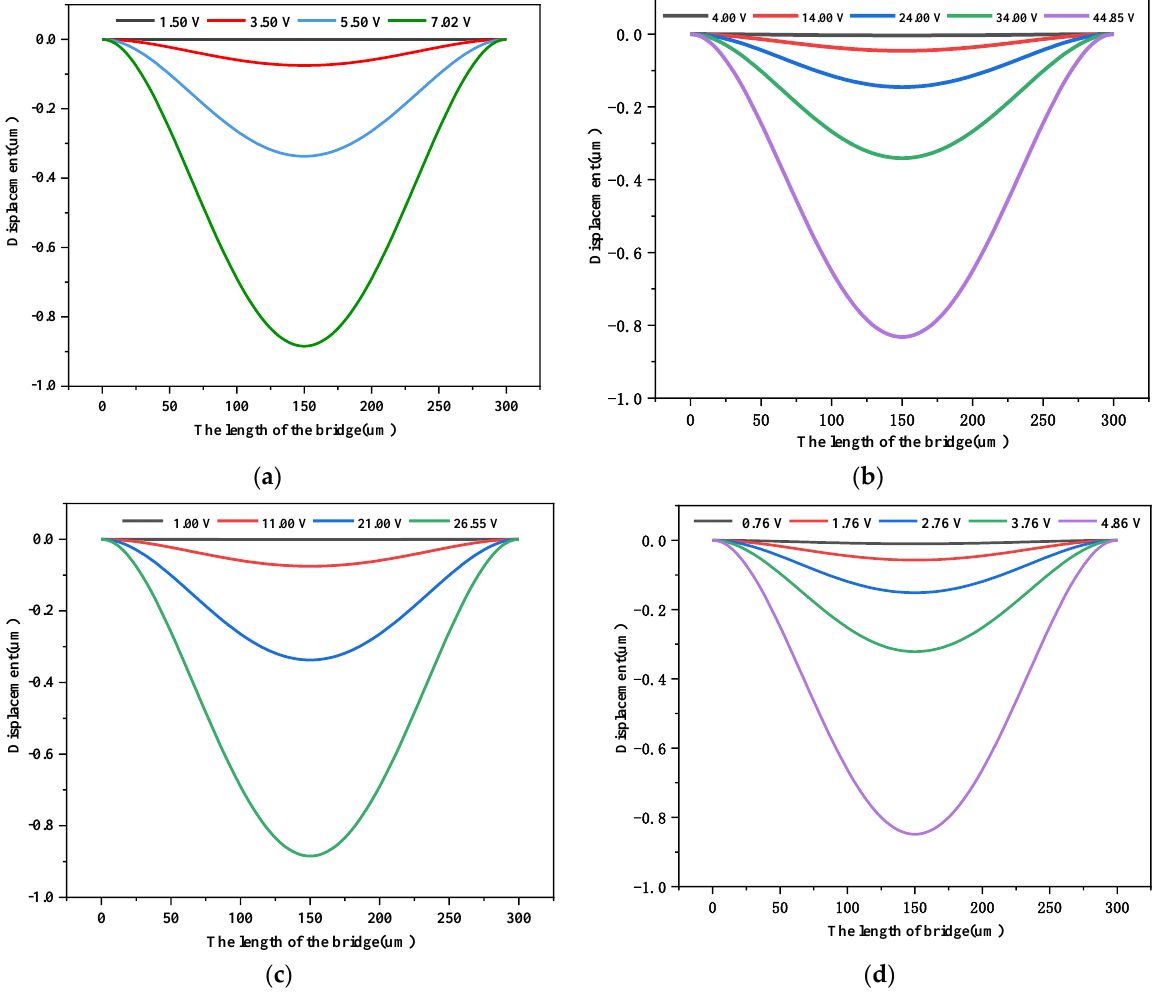
Figure 5. The relationship curves between the deflection of the switch and the control voltage filled with different materials: ( a ) the surrounding dielectric is air; ( b ) the surrounding dielectric is glycerol; ( c ) the surrounding dielectric is silicone oil; ( d ) the surrounding dielectric is water. From Figure 5, it can be seen that the threshold voltage of the RF MEMS switch is different when air, glycerin, silicone oil, and water are filled into the switch, namely 44.85 V, 7.02 V, 26.55 V, and 4.86 V, respectively. After the four media shown in the figure are filled into the switch, the threshold voltage of the switch changes in the same direction. When the applied control voltage causes the switch to drop one-third of its height, the cantilever bar has a large deflection in the range of a small voltage as the control voltage continues to increase. The dielectric constant of the filling medium is 37 for glycerol, 2.6 for silicone oil, and 78.36 for water. The calculation shows that the threshold voltage de- creases to 1/ε as the dielectric constant of the environment increases. This suggests that the threshold voltage of the RF MEMS switch can be effectively reduced by encapsulating a high dielectric constant insulating liquid. 4.2. Effect of Change of Switch Filling Material on Response Time The study of the fall time of the switch shows that different filler media have different threshold voltages, and the cantilever beam starts to fall only when the drive voltage reaches a certain value. In addition, the fall time of the switch decreases as the drive volt- age increases. Figure 6 shows the curves of response time and drive voltage. It can be seen from Figure 6 that the response time of the switch decreases with the increase of the drive voltage when four dielectrics are used as the filling material. In addition, the response time of the switch decreased rapidly near the threshold voltage and decreased slowly as the threshold voltage increases. Therefore, the trigger voltage slightly above the threshold voltage should be selected to ensure normal triggering of the RF MEMS switch and to reduce the response time of the switched RF MEMS. However, a high drive voltage in- creases the shock rate of the cantilever and the dielectric charging effect, shortening the lifetime of the switch. Therefore, setting the drive voltage at one and a half to two times the threshold voltage is a more reasonable approach. The drive voltage is about 19.5 V with glycerol as the filler material of the switch, 35.2 V with silicone oil as the filler mate- rial, 7.1 V with water as the filler material, and 44.1 V with air as the filler material. Exper- imental results show that the response time of the RF MEMS switches filled with different media is less than 46.2 μs.